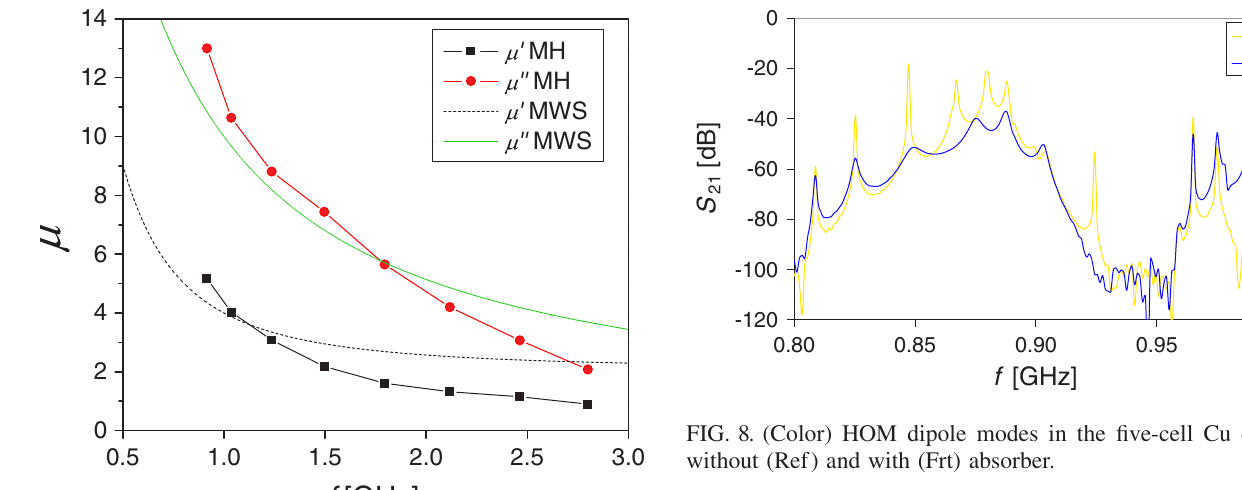
FERRITE-DAMPED HIGHER-ORDER . .